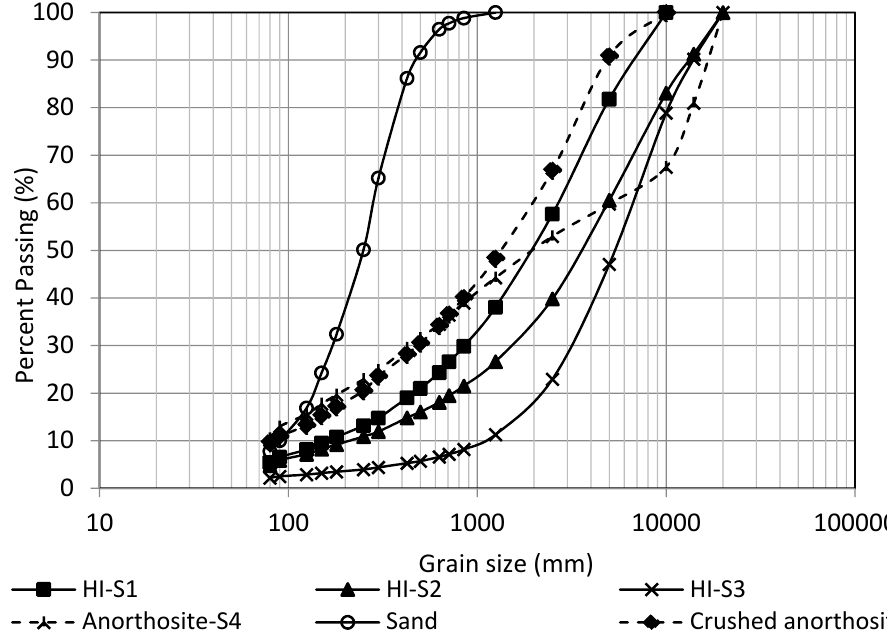
Figure A2. Grain size distribution curves for the materials in the laboratory experiment [31].